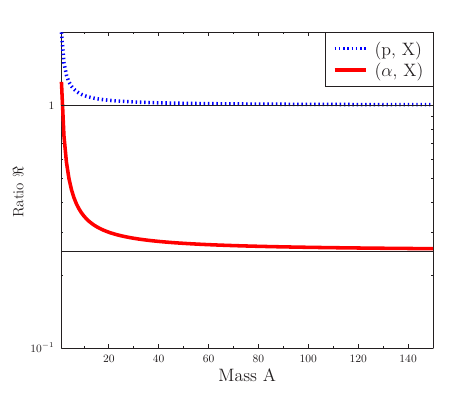
/ E defined here as E ∗ Figure 2. The kinematical ratio CM , lab (cid:31) in which E ∗ is given in the typical units of MeV / A used for lab the beam energy. If e .g. a ( p ,γ ) reaction with A = 59 needs to be studied in inverse kinematics and the Gamow window centers at 4 MeV, a beam energy of ( A = 59) 4 = 4 . 1 MeV / A is required. On the other hand, (cid:31) × for the same mass but an ( α,γ ) reaction, a beam energy of 1.3 MeV / A is required (since 0 . 3), which is (cid:31) ≈ experimentally much more challenging.